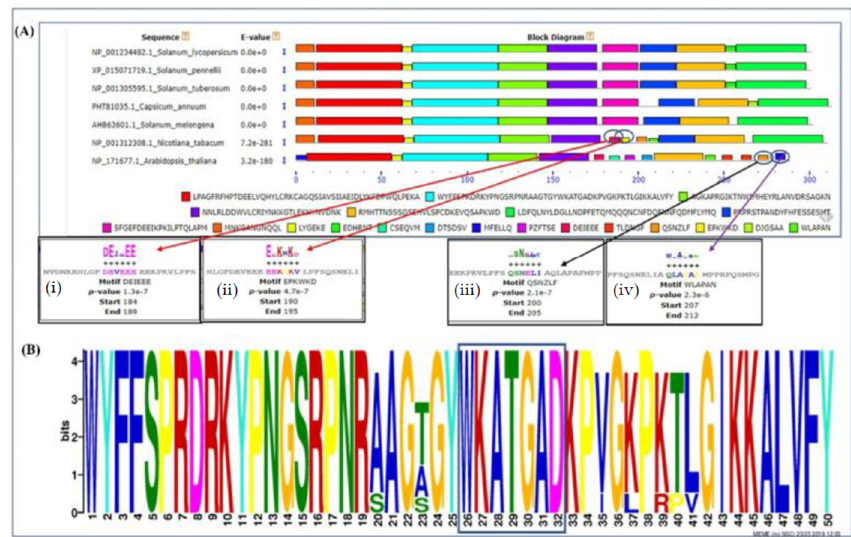
Figure 3. ( A ) The conserved motif analysis shows the distribution of common and uncommon mo- tifs found in S. lycopersicum , S. pennelli , S. tuberosum , C. annum , S. melongena , N. tabacum and A. tha- liana . ( B ) The sequential logo of motif